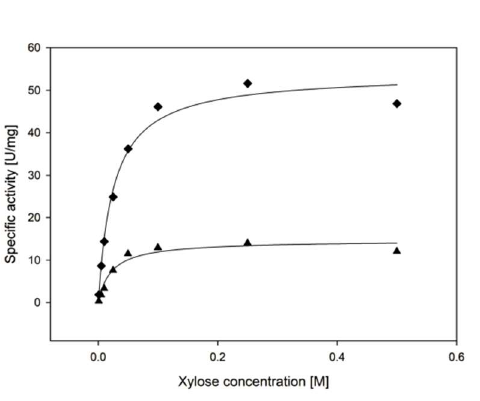
Figure 2. Michaelis-Menten curves at ▲ 30 °C and ◆ 55 °C. The concentration of D -xylose was varied and concentration of NADPH was kept at 0.4 mM.